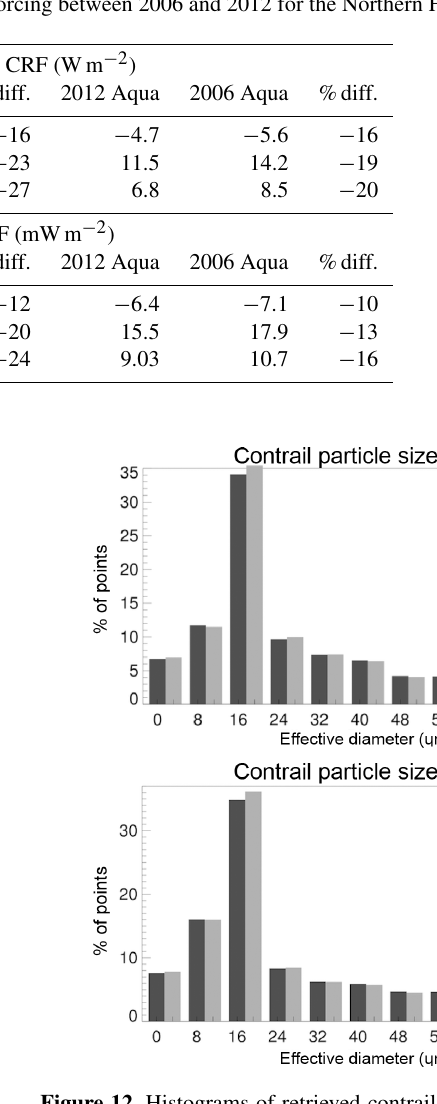
Figure 11. Histograms of retrieved contrail τ computed from 2006 and 2012 Terra MODIS data.